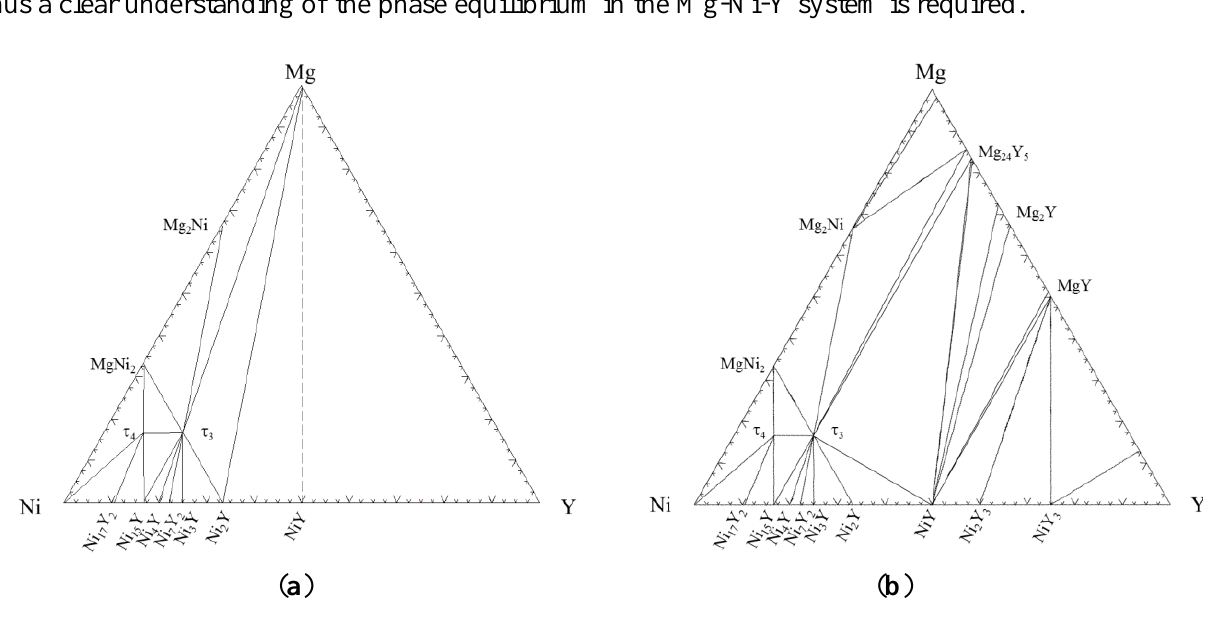
Figure 1. ( a ) Isothermal section of the Mg-Ni-Y system at 673 K (Ni-rich part) [11]; ( b ) Calculated isothermal section of the Mg-Ni-Y system at 673 K